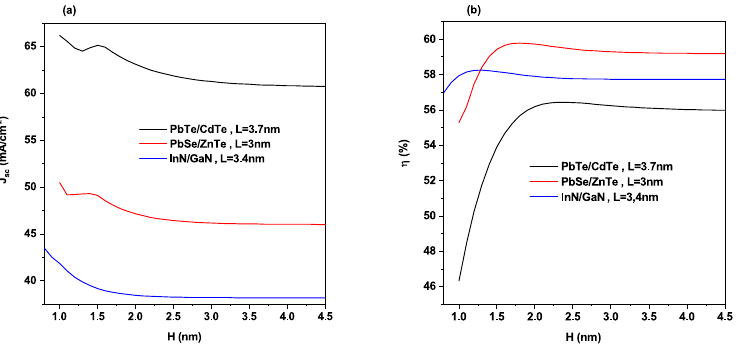
Figure 10. ( a ) Variation of J sc and ( b ) photovoltaic conversion efficiency of QD-IBSC structure versus H at the optimum dot size L = 3.7 nm, 3 nm and 3.4 nm for PbTe/CdTe, PbSe/ZnTe and InN/GaN QD